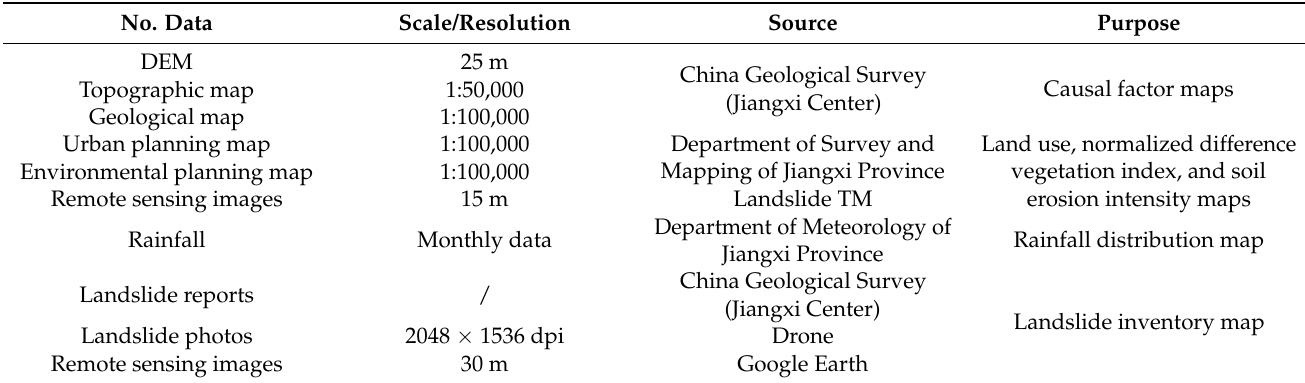
Table 1. Data sources used in this